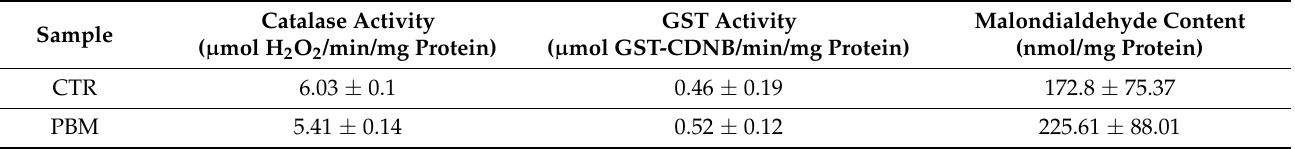
Table 1. Oxidative stress enzyme activity and malondialdehyde content in Chondrosia reniformis 6 h postirradiation. The samples were normalized to total protein